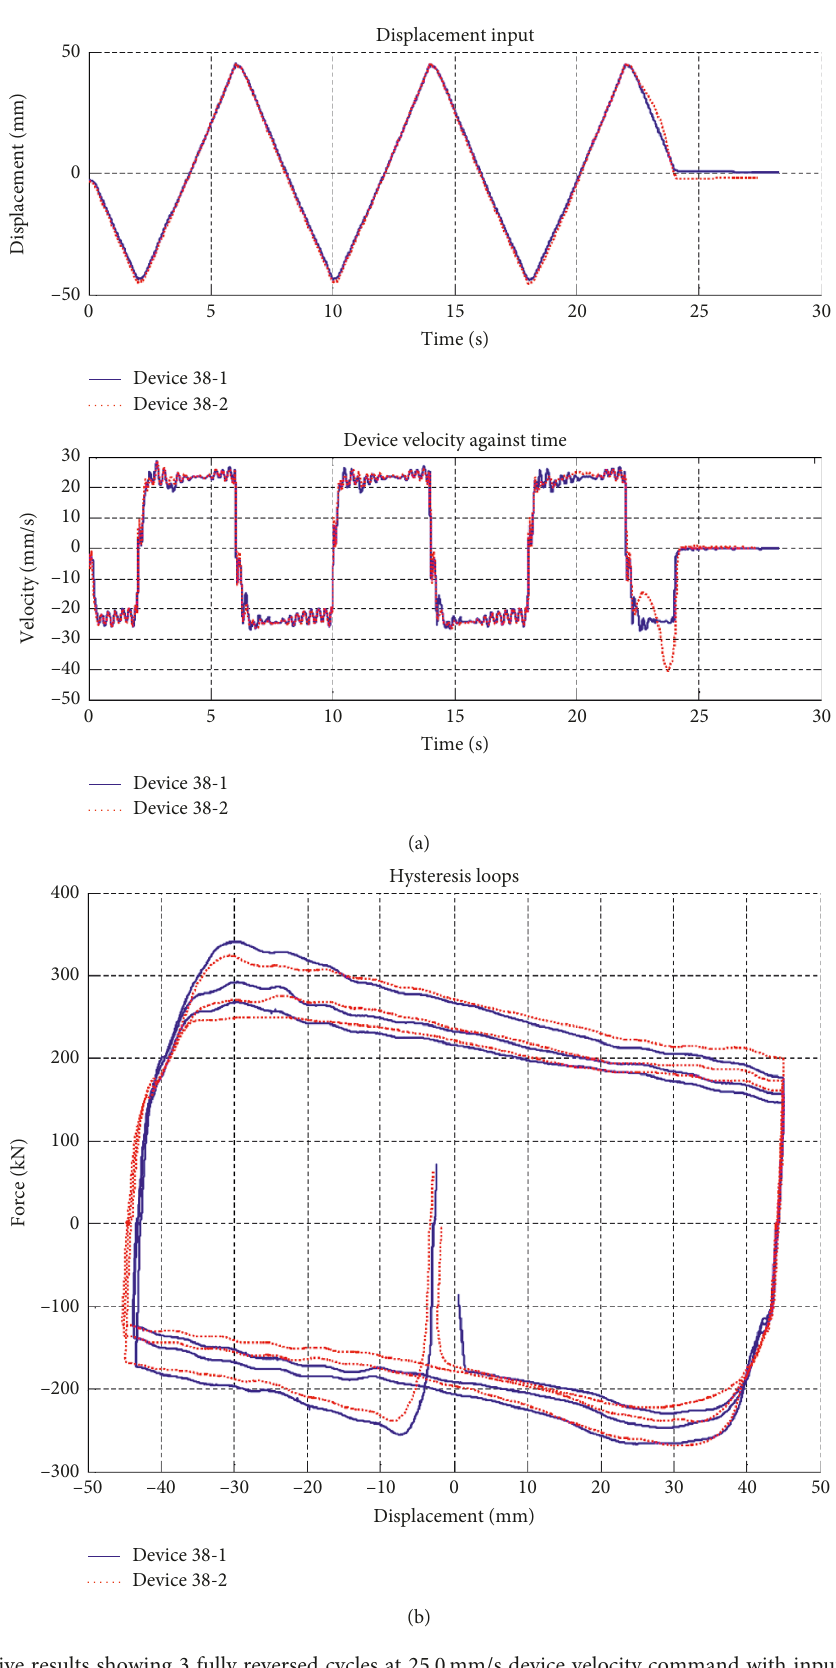
Figure 6: Representative results showing 3 fully reversed cycles at 25.0mm/s device velocity command with inputs of displacement and velocity (a) and resulting hysteresis loops